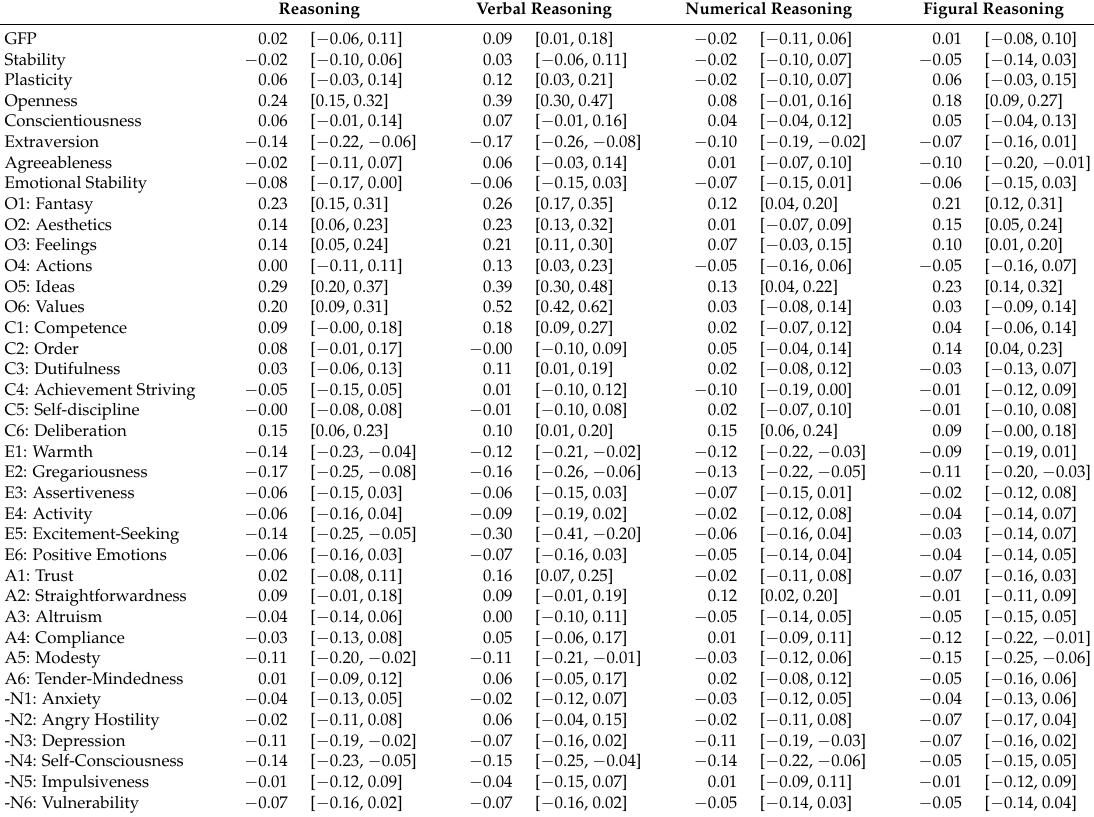
Table A1. Study 1: Bootstrapped disattenuated correlations (controlled for gender). 95% CI in brackets. Reasoning Verbal Reasoning Numerical Reasoning